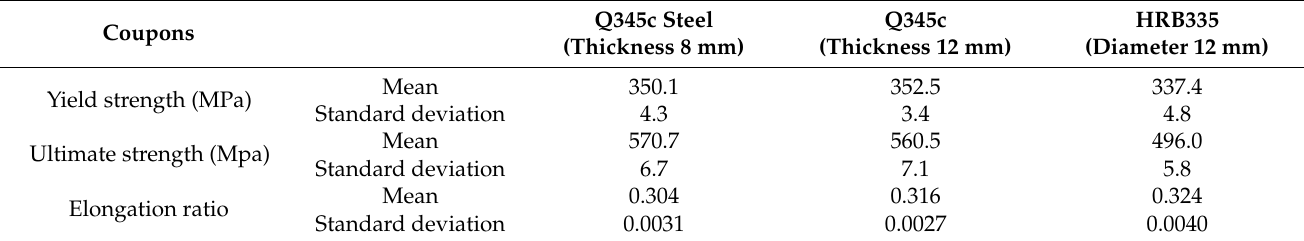
Table 2. Material properties of the steel plates and rebar coupons.